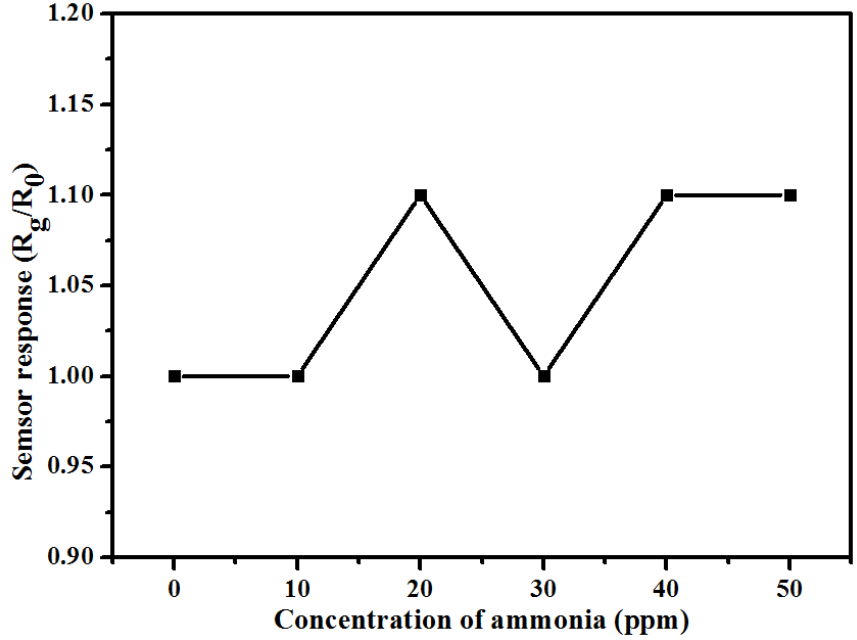
Figure 7. Sensor responses of TiO 2 NPs to NH 3 gas ranging from 10 to 50 ppm at room temperature.